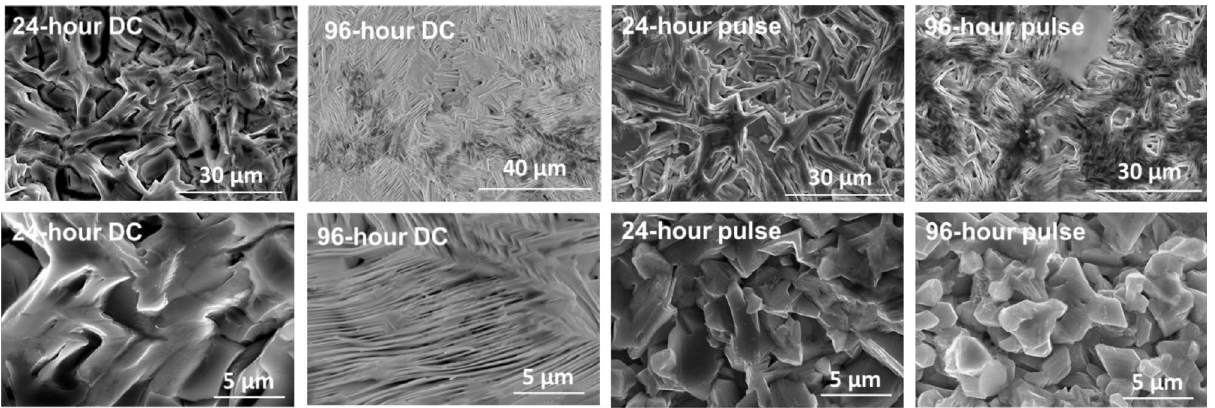
Figure 3. Scanning electron microscopy (20 kV accelerating voltage) of electroplated bismuth at various